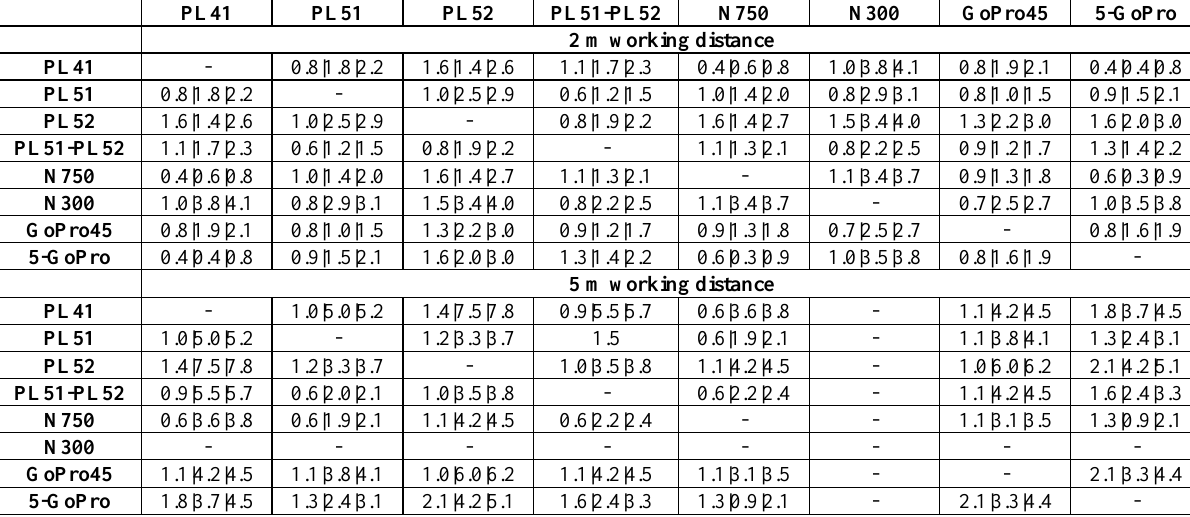
Table 5: Comparison of photogrammetric BA between the different camera systems: RMSE XY |RMSE Z |3D_RMSE XYZ of differences computed on the nine coded targets 3D coordinates (values are in